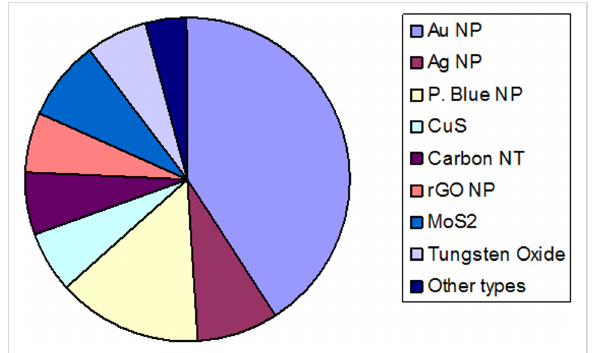
Figure 1: Pie chart showing the ratio of photothermally active nanopar- ticles (NPs) used for the temperature-induced bacteria and biofilm